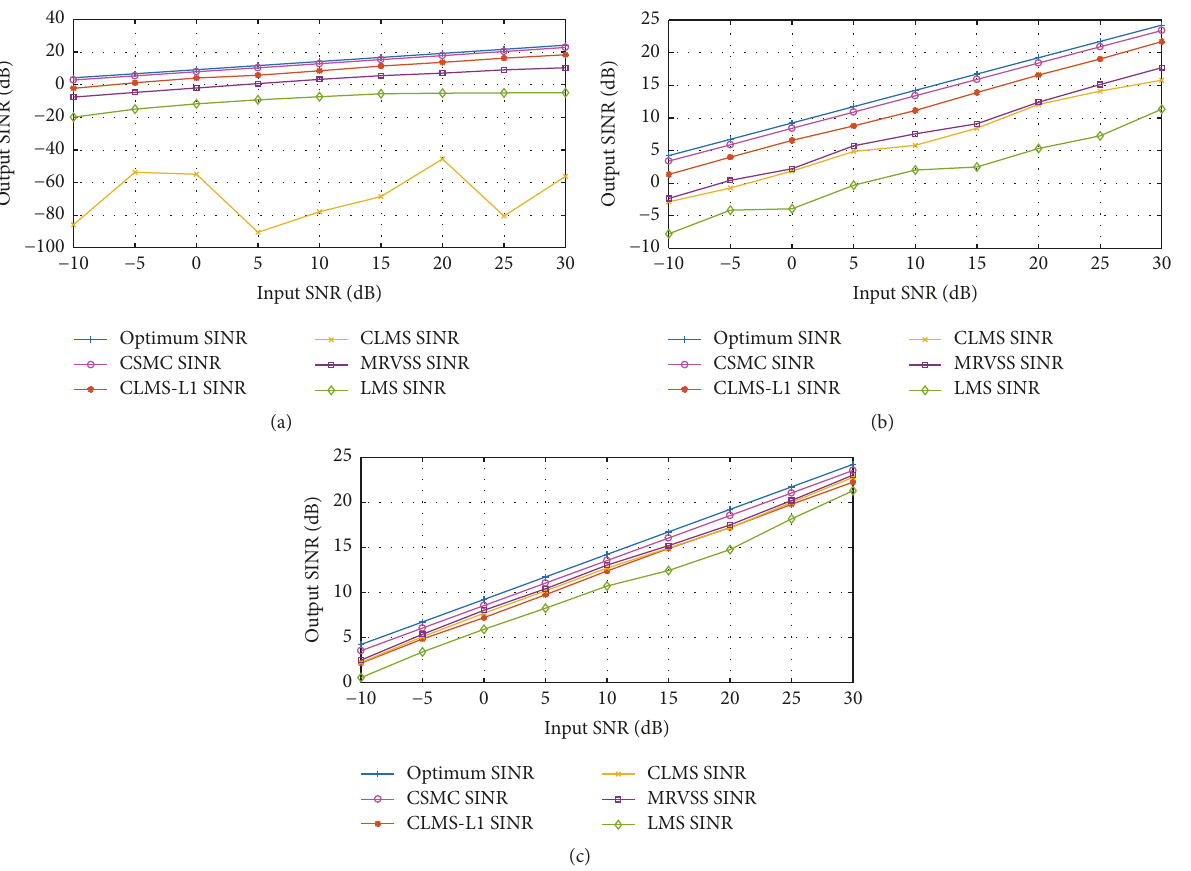
Figure 3: SINR performance against SNR with different 𝛼 : (a) 𝛼 = 1.05 ; (b) 𝛼 = 1.25 ; (c) 𝛼 = 1.45